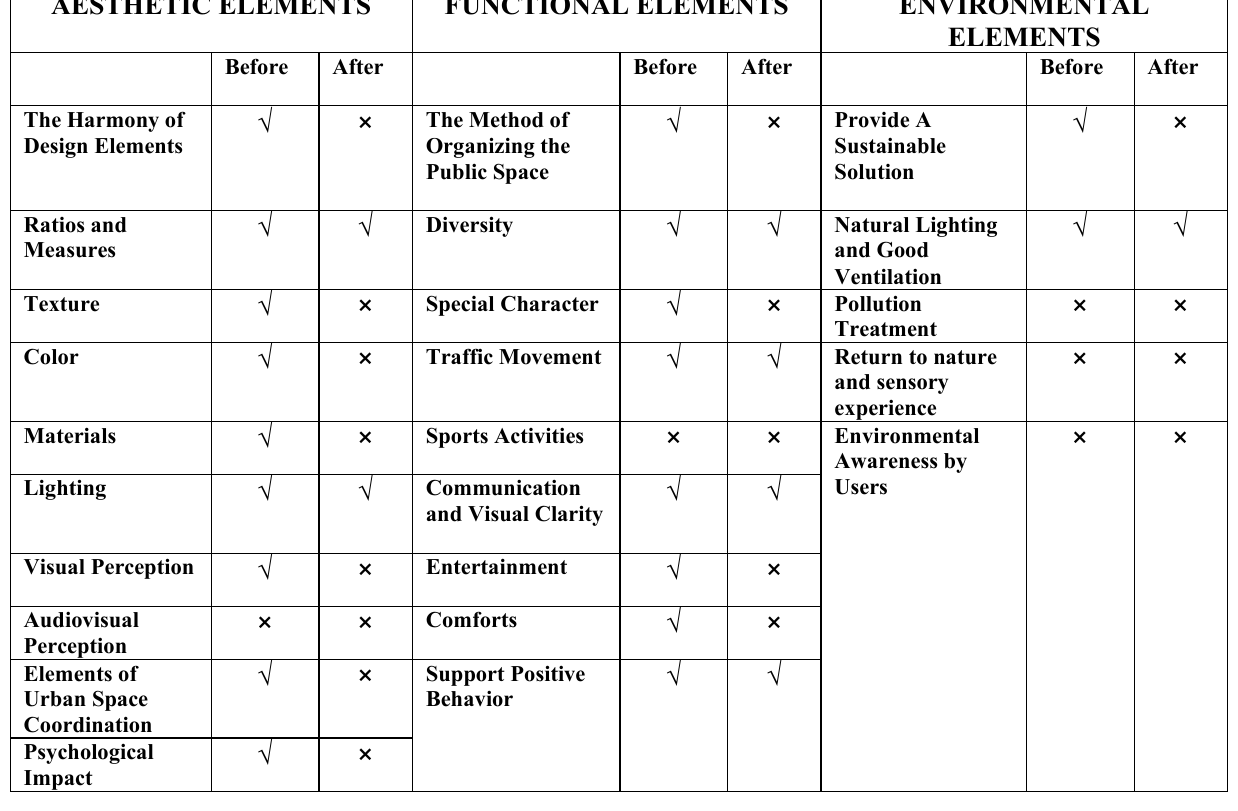
Table 9. Analysis of "Şışhane Park" according to derived aesthetic, functional and environmental standards; (Improved by authors). AESTHETIC ELEMENTS FUNCTIONAL